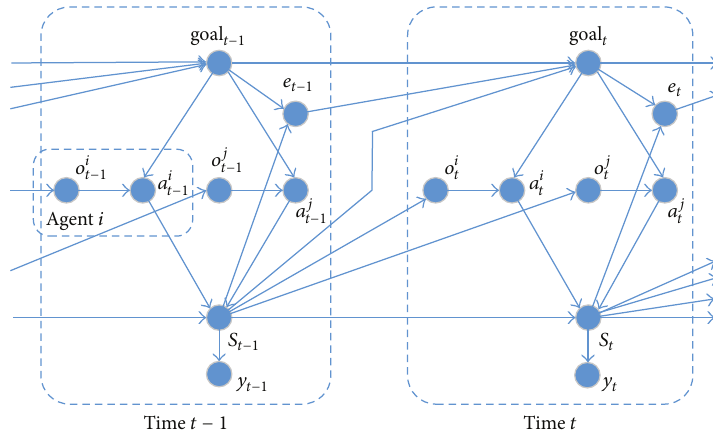
Figure 1: The DBN representation of the Dec-POMDM in two adjacent time